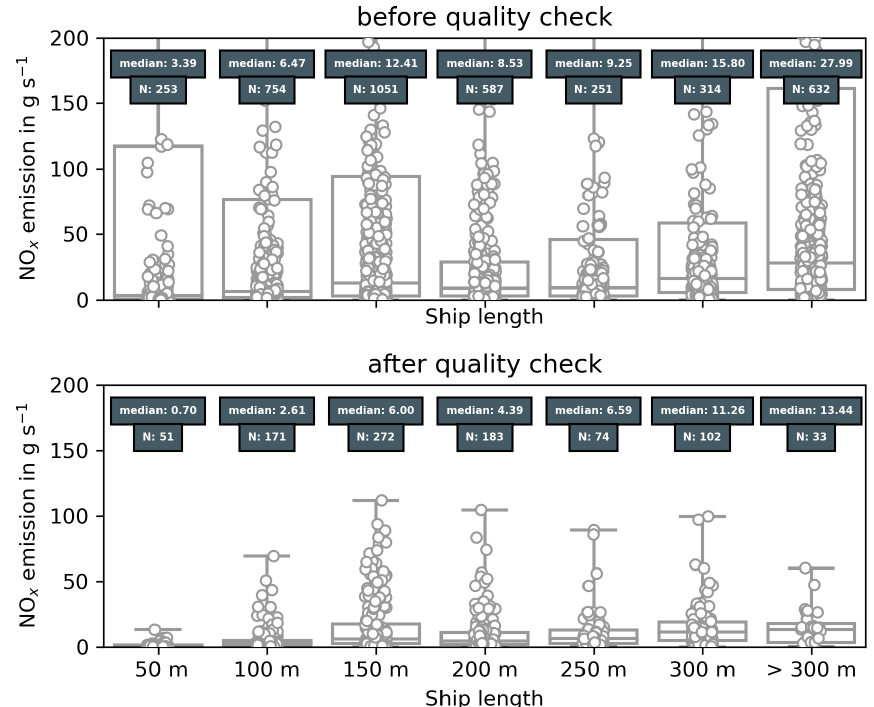
Figure 5. Box plot of NO x emission rates in grams per second for different ship sizes. Boxes indicate the 25th and 75th percentile, the line in the middle is the median and the bars show minimum and maximum values. Dots show individual measurements. Dark grey boxes show the median emission rate and total number of observations for this length